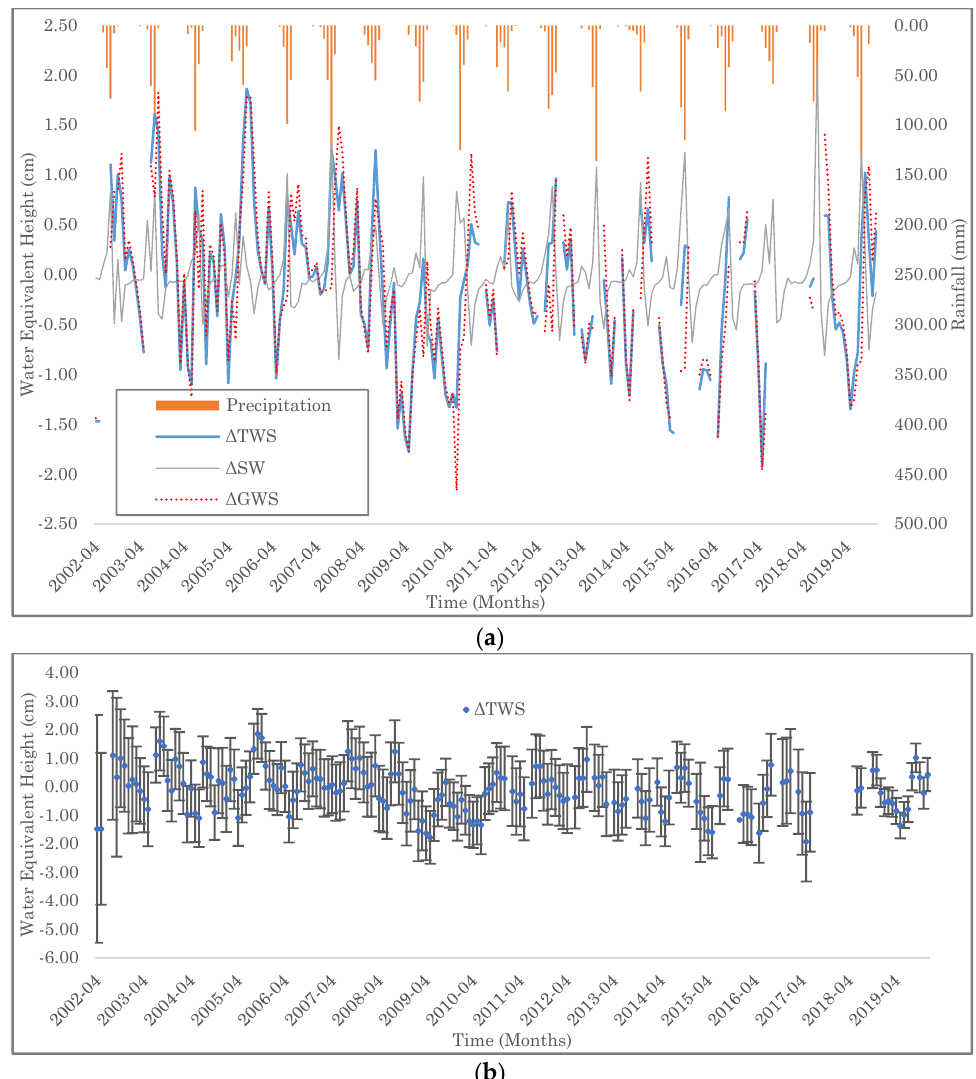
Figure 2. ( a ) Monthly precipitation and in TWSC, GWSC, and, SWC in the TMB and ( b ) GRACE data uncertainty band.